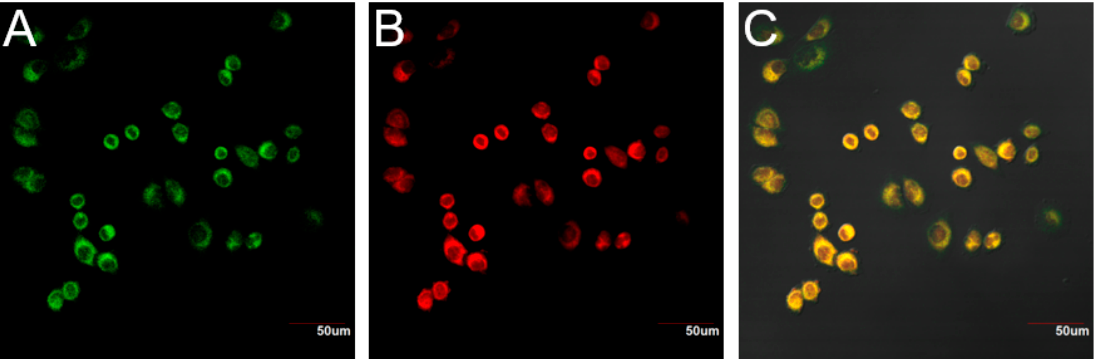
Figure 6. Confocal microscopy images of mitochondrion by 1 in living cells. Cells were co-stained with 1 (5 µM), D-Cys (100 µM) and commercial MitoTracker ® Green FM (2.5 µM). ( A ) The cell image displayed by green channel (500–530 nm, excitation at 488 nm). ( B ) The cell image displayed by red channel (620–660 nm, excitation at 594 nm). ( C ) Merged graph of fluorescence images of 1 and MitoTracker ® Green FM. Scale bars: 50 µm.